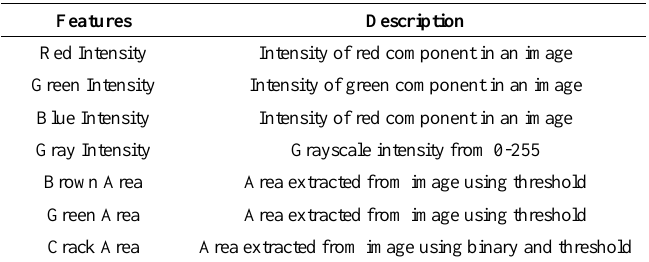
Table 1. Feature extraction for image segmentation